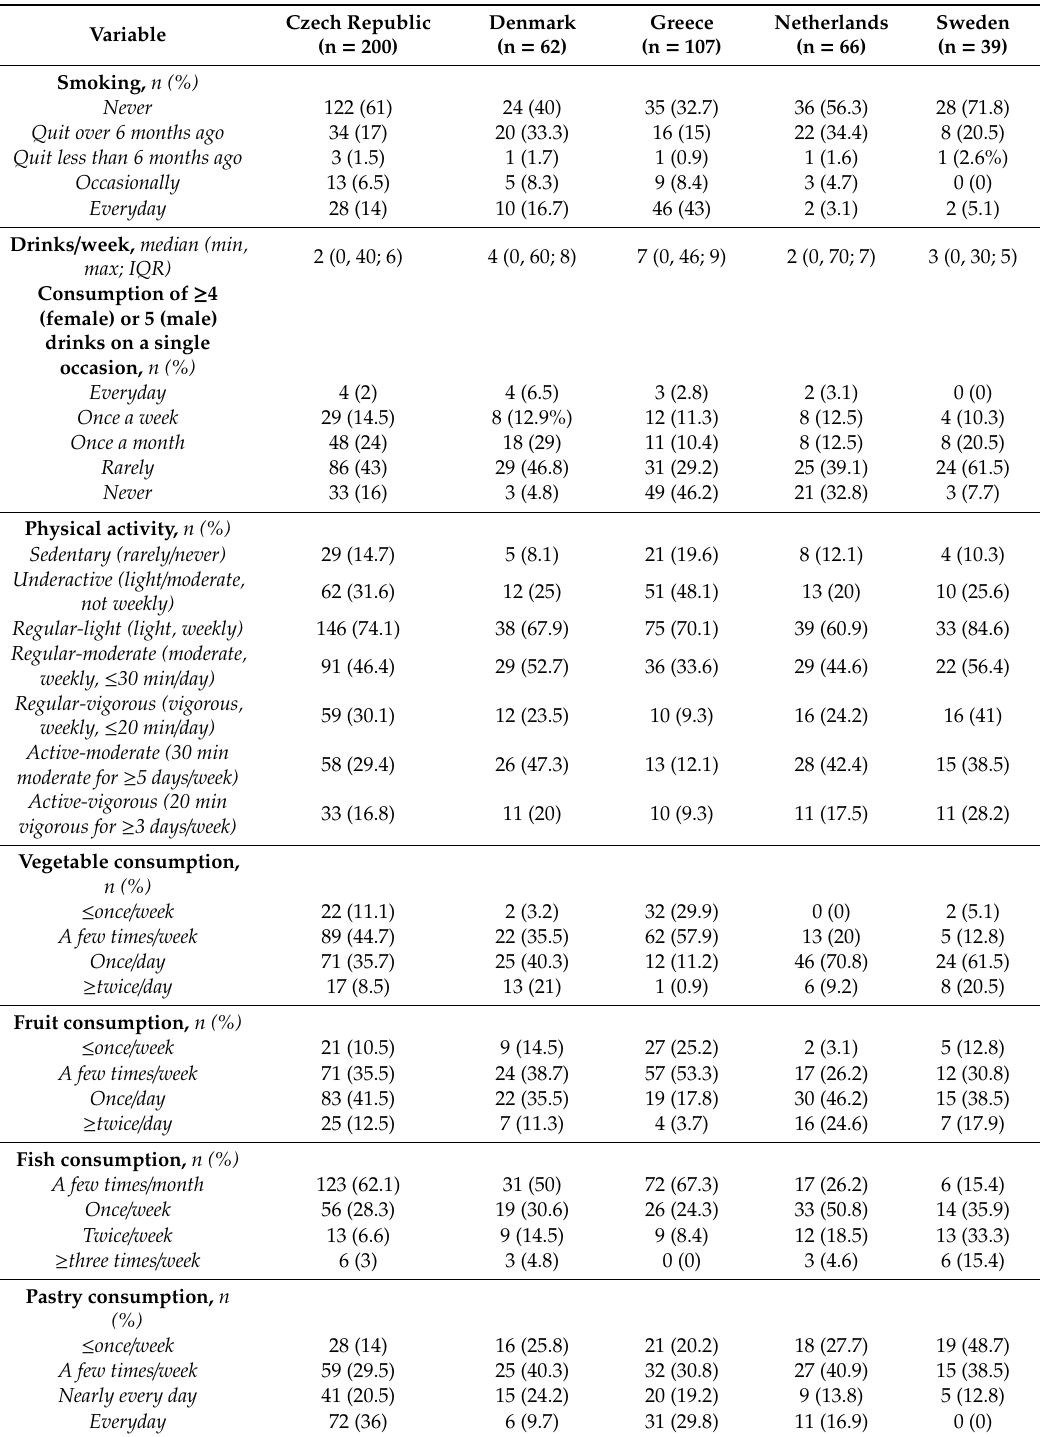
Table 2. Lifestyle-related cardiometabolic risk factors of individuals accepting invitation per country (n = 474).